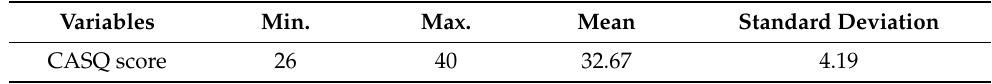
Table 6. Values (extreme, mean, and standard deviation) for CASQ